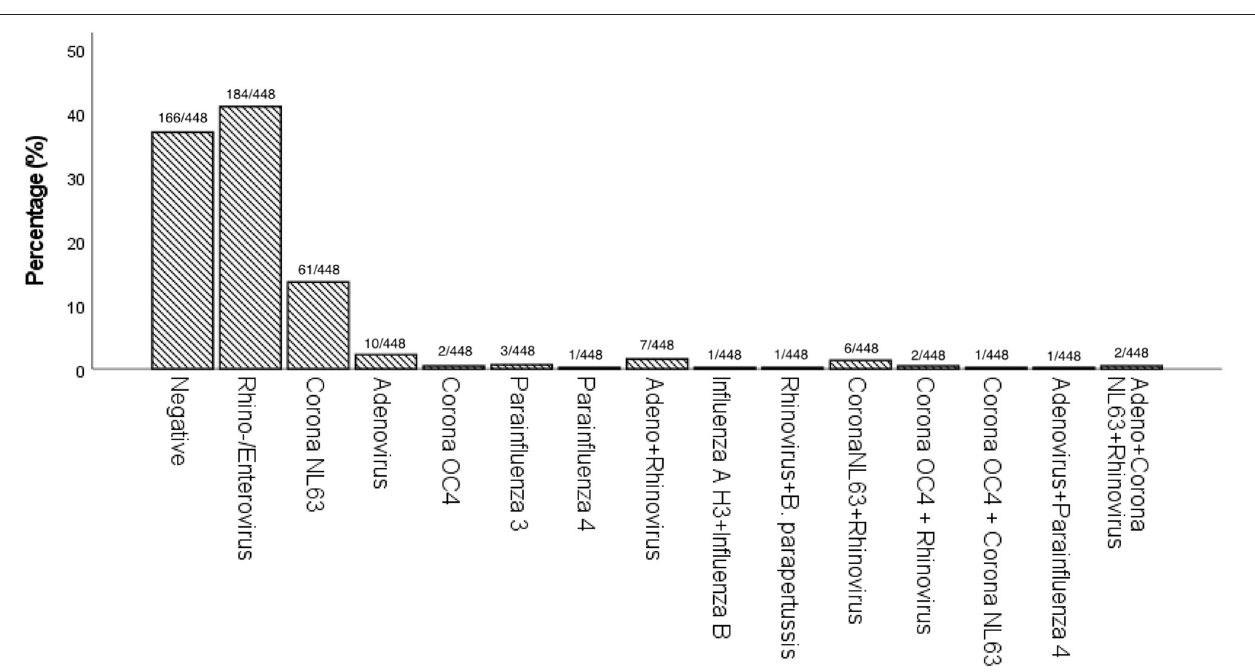
FIGURE 1 | Prevalence (%) of pathogens detected in single and co-infections by Multiplex PCR.